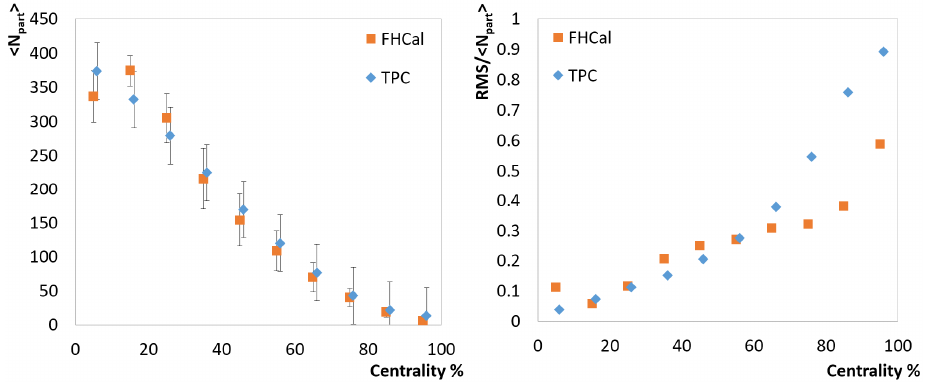
Figure 5. Mean values of the number of participants with error bars that denote the standard deviations of the participants’ distributions for the given centrality class (left) and the relative standard deviations of participants’ distributions (right) for two methods of centrality determination.